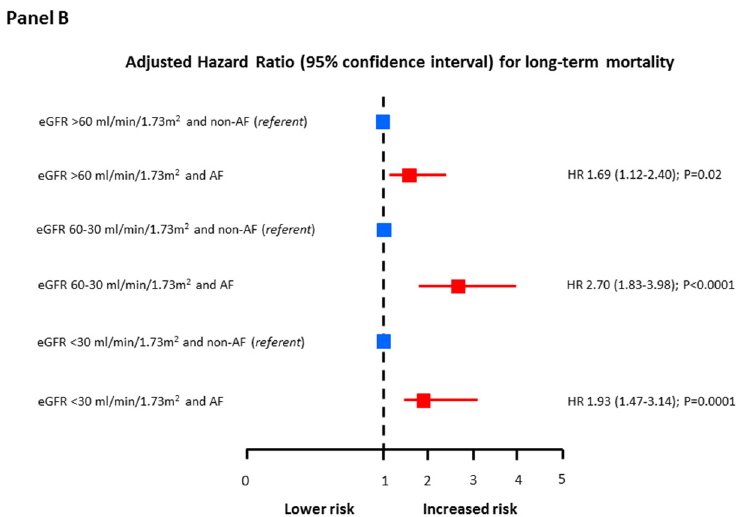
Figure 4. ( Panel A ) Long-term all-cause mortality rate in the three study groups according to AF (yes vs. no). In particular, the reported mortality rate refers to the events observed during the entire follow-up period (median 5 (1.2–8.5) years). ( Panel B ) Adjusted hazard ratios (HR) and 95% confidence intervals for long-term mortality according to AF in each study group. Hazard ratios were adjusted for independent predictors of long-term mortality, identified by logistic regression analysis with stepwise selection of variables (age, diabetes mellitus, acute myocardial infarction type, prior myocardial infarction, and left ventricular ejection fraction) in the entire study population.